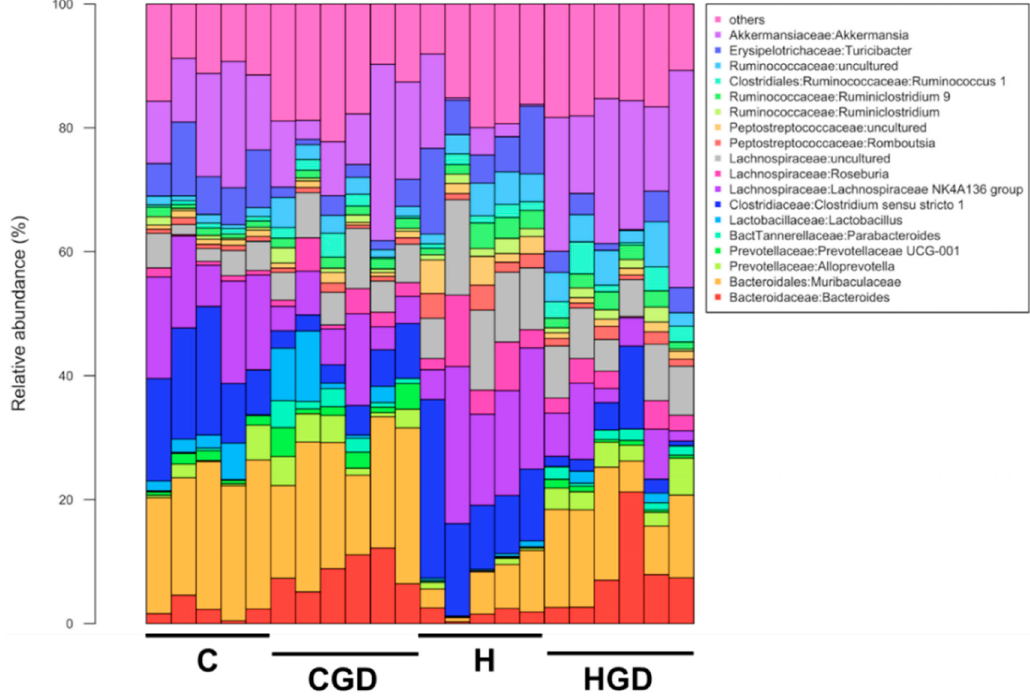
Figure 12. Taxonomic profiles of bacterial communities shown at the genus level. C, corn starch diet-fed rats; CGD, corn starch diet-fed rats treated with Garcinia dulcis rind powder; H, high-carbohydrate, high-fat diet-fed rats; HGD, high-carbohydrate, high-fat diet-fed rats treated with Garcinia dulcis rind